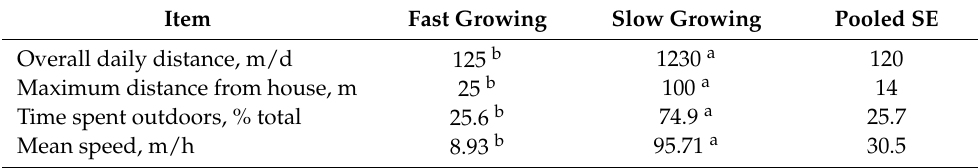
Table 1. Global positioning system average outcomes of organic chickens. Modified from [12]. Item Fast Growing Slow Growing Pooled SE Overall daily distance, m/d 125 b 1230 a 120 Maximum distance from house, m 25 b 100 a 14 Time spent outdoors, % total 25.6 b 74.9 a 25.7 Mean speed, m/h 8.93 b 95.71 a